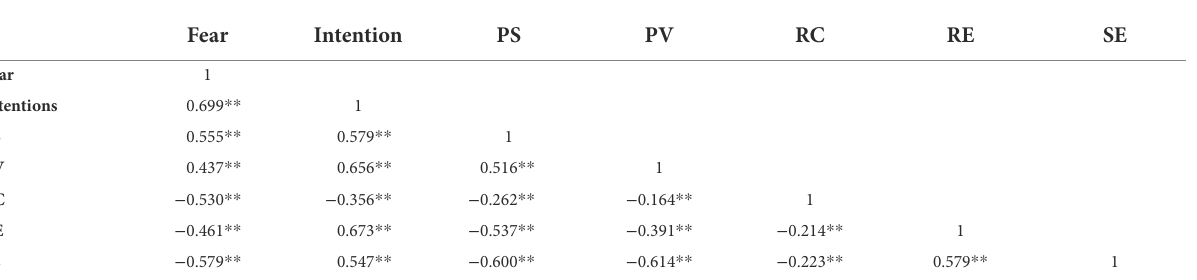
TABLE 2 Correlations matrix of the